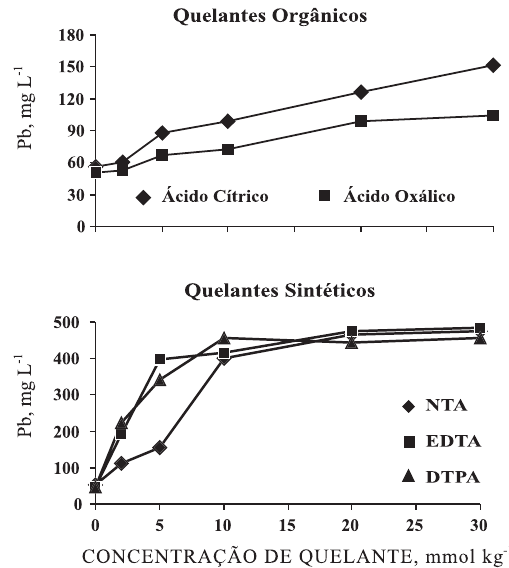
Figura 1. Efeito da aplicação dos quelantes (EDTA, NTA, DTPA, ácido cítrico e oxálico nas concentrações de 0, 2, 5, 10, 20 e 30 mmol kg -1 ) na dessorção de Pb (mg L -1 ) no solo.